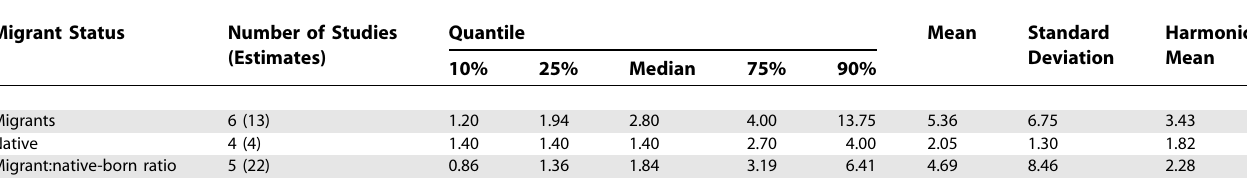
Table 10. Quantiles and Moments of Combined Prevalence Estimates per 1,000 for Persons by Migrant Status, and Migrant:Native- Born Prevalence Estimate